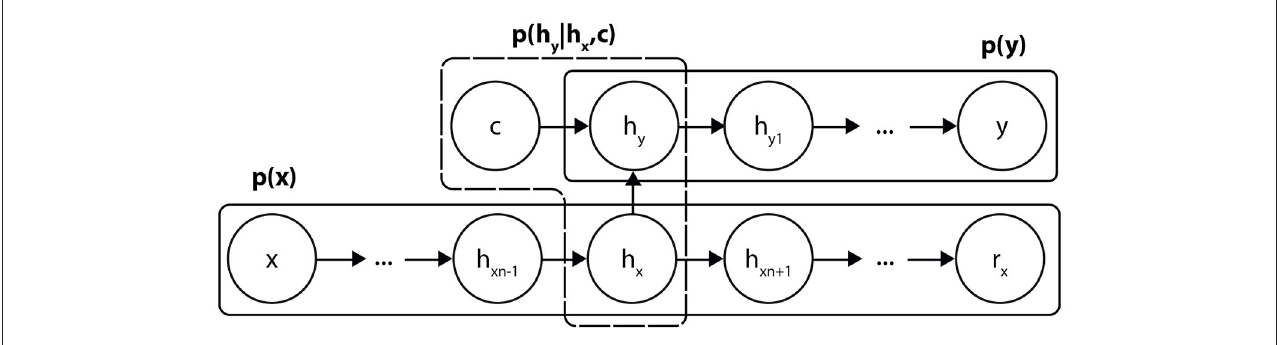
FIGURE1 Breakdown of the DCAE into three